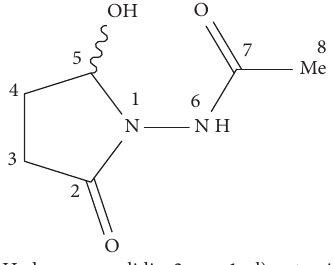
Figure 1: Structure of new compound isolated from R. oligophlebia